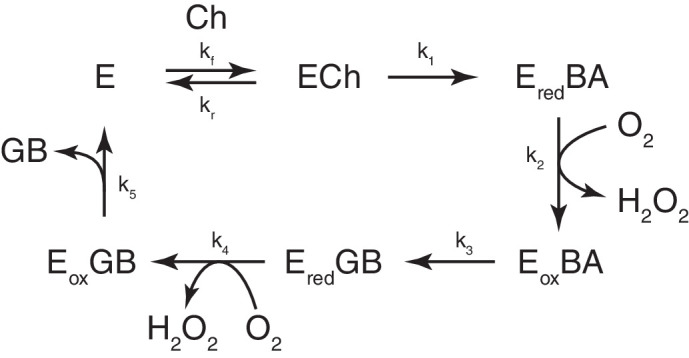
Minimal kinetic mechanism of Choline Oxidase.(E) Free enzyme, (ECh) enzyme-bound Ch, (Ered) enzyme with reduced FAD co-factor, (Eox) enzyme with oxidized FAD co-factor, (BA) betaine aldehyde, (GB) glycine betaine.